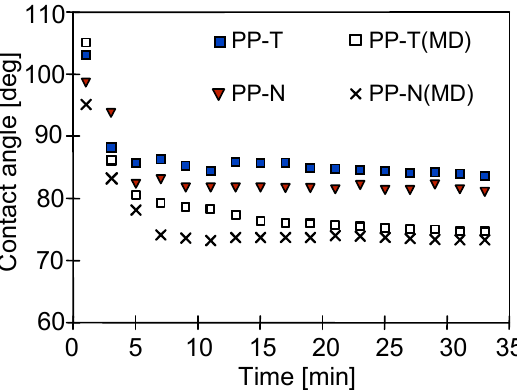
Figure 7. The changes of the contact angle (advancing) during continuous measurements of dynamic contact angle using the Wilhelmy plate method. Samples of new membranes and membranes collected from modules after 350 h of MD process.